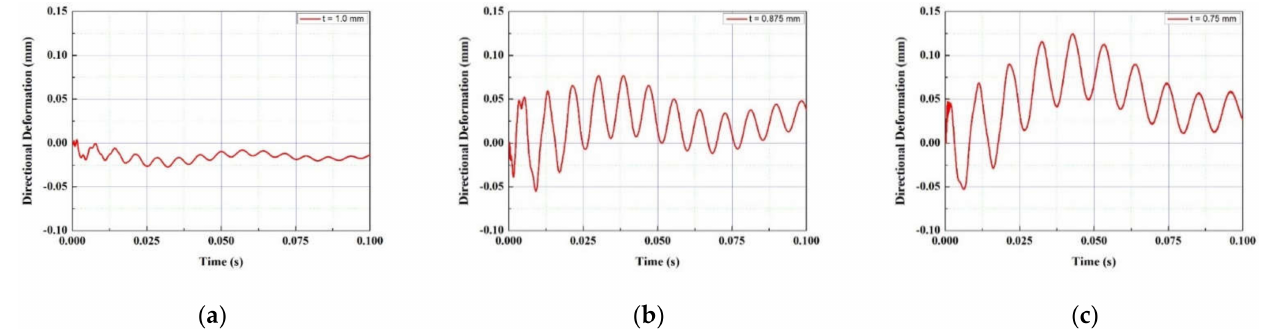
Figure 9. Vibration displacement according to piezoelectric thickness (t): ( a ) 1.0 mm; ( b ) 0.875 mm; ( c ) 0.75